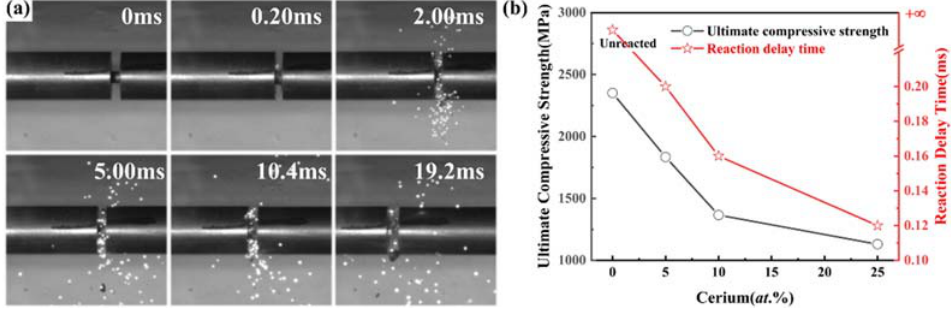
Figure 7. ( a ) Dynamic compression process of Ce5 at 1200 s − 1 and ( b ) ultimate compressive strength and reaction delay time of